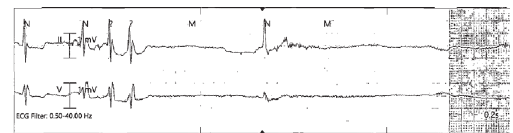
Figure 2: Telemetry strip during one of the syncope episodes showing a junctional escape beat overlaying a sinus arrest (6-second pause) proceeded by premature atrial